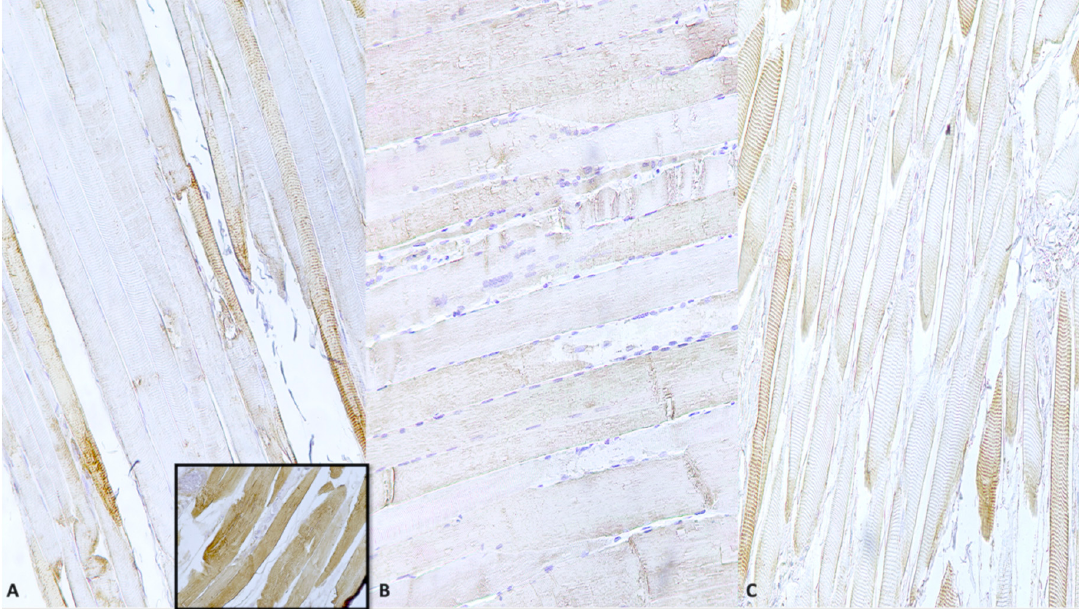
Figure 2. ( A ) Clear decrease in staining with some positivity (brown color) remaining (Grade II) ( × 100). Insert: positive control. ( B ) Scarce positive TnI fast (brown) intracytoplasmic staining (Grade II) ( × 100). ( C ) High intracytoplasmic depletion of Troponin I with scarce positivity (Grade II) (×80).